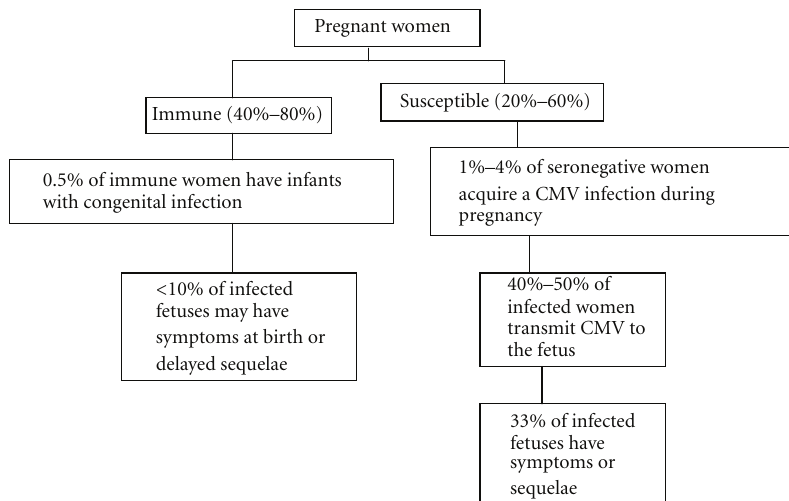
Figure 1: Relationship of maternal immunity to disease caused by congenital CMV infection. Adapted from